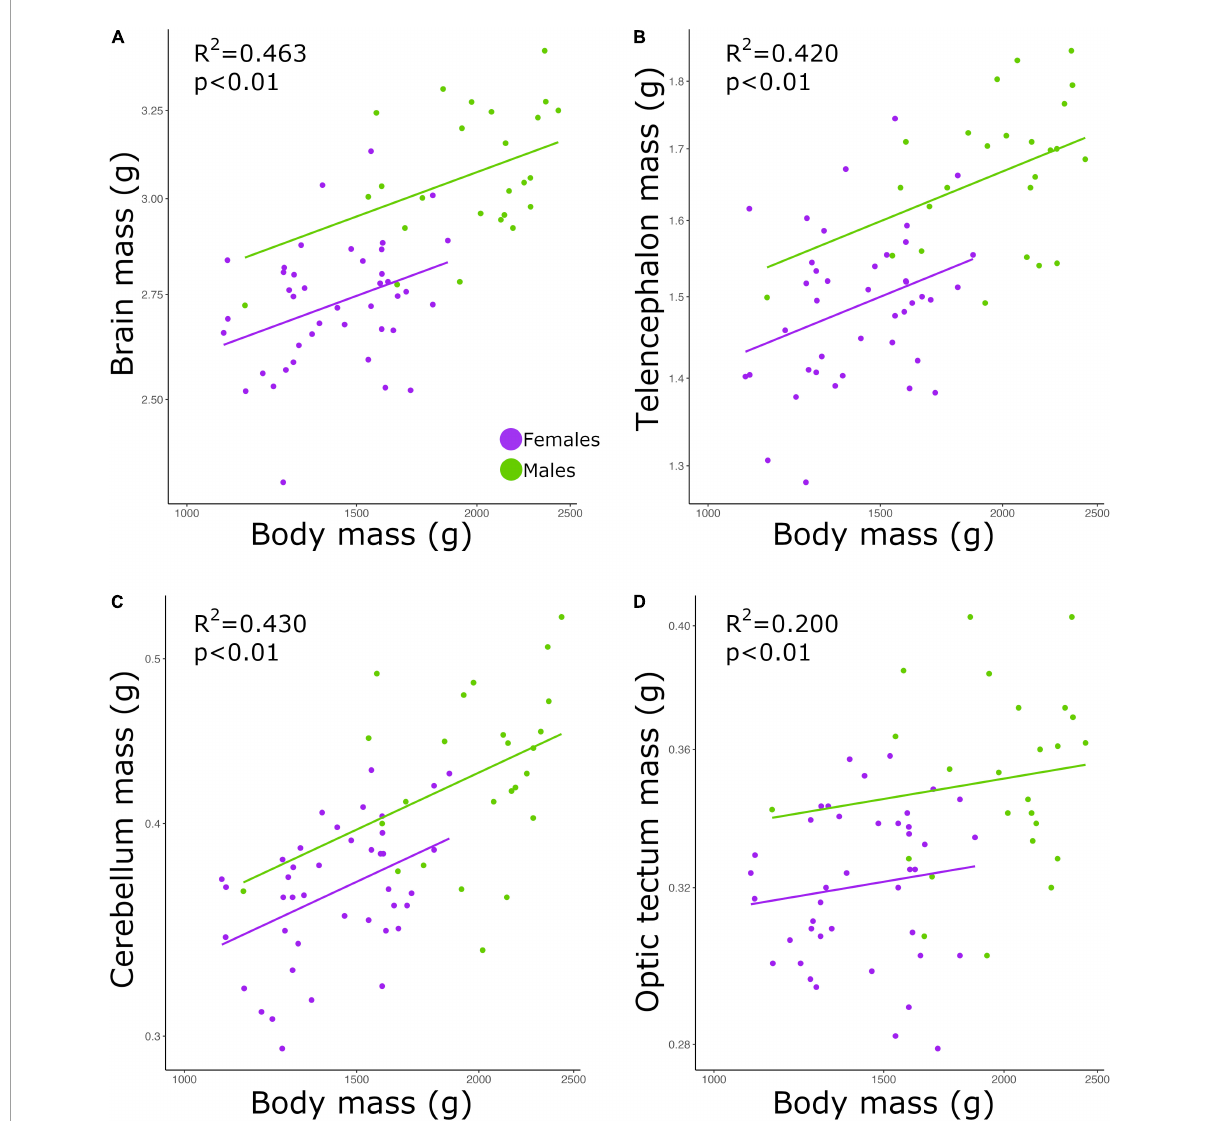
FIGURE1 Scatterplots of the masses (g) of the (A) brain, (B) telencephalon, (C) cerebellum, and (D) optic tectum against the mass (g) of the body. In all graphs, males are shown in green, and females are shown in purple.